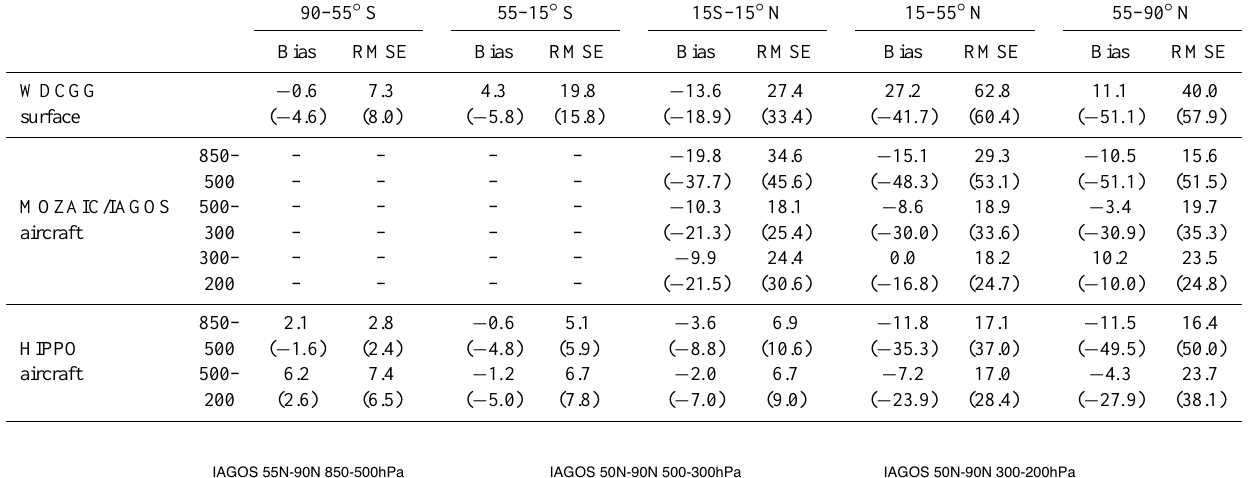
Table 4. Same as Table 1, but for mean CO concentrations. Units are ppb. Observations used are the WDCGG observations during 2005– 2012, MOZAIC/IAGOS aircraft measurements during 2005–2012, and HIPPO aircraft measurements during 2009–2011.